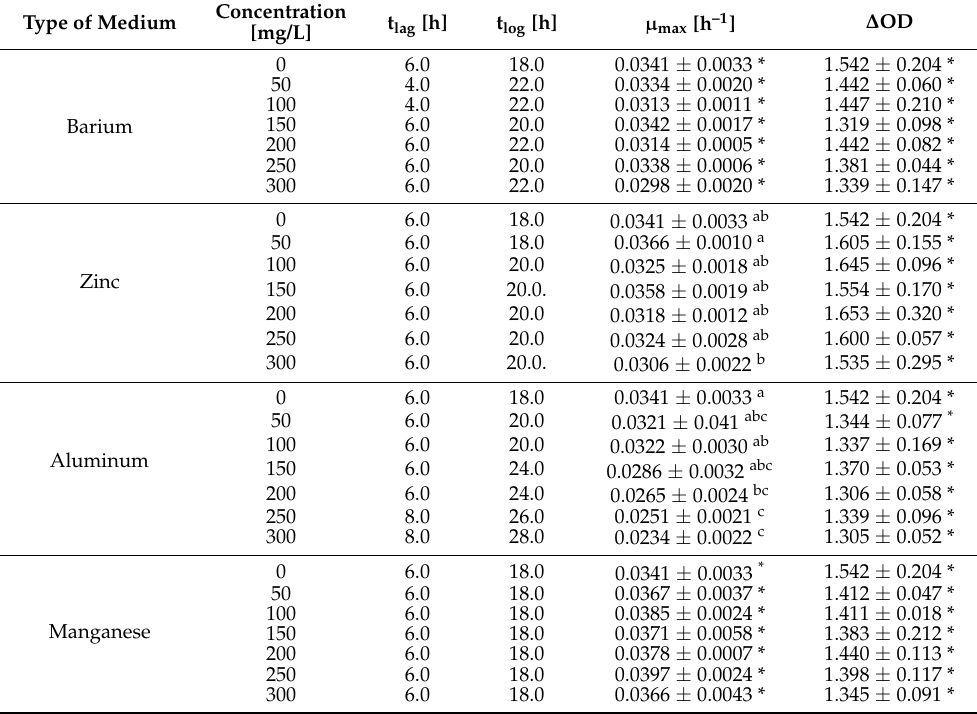
Table 1. Growth characteristics of Rhodotorula mucilaginosa MK1 yeast observed in Bioscreen C during cultivation in media containing different